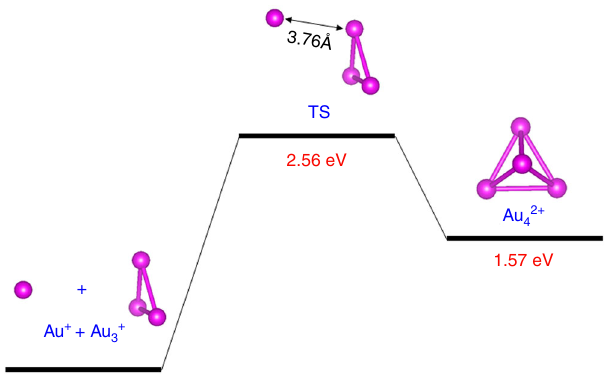
Fig. 1 The computed reaction pathway for the Au + + Au 3 + ← → Au 4 2+ reaction. Color code: Au — magenta